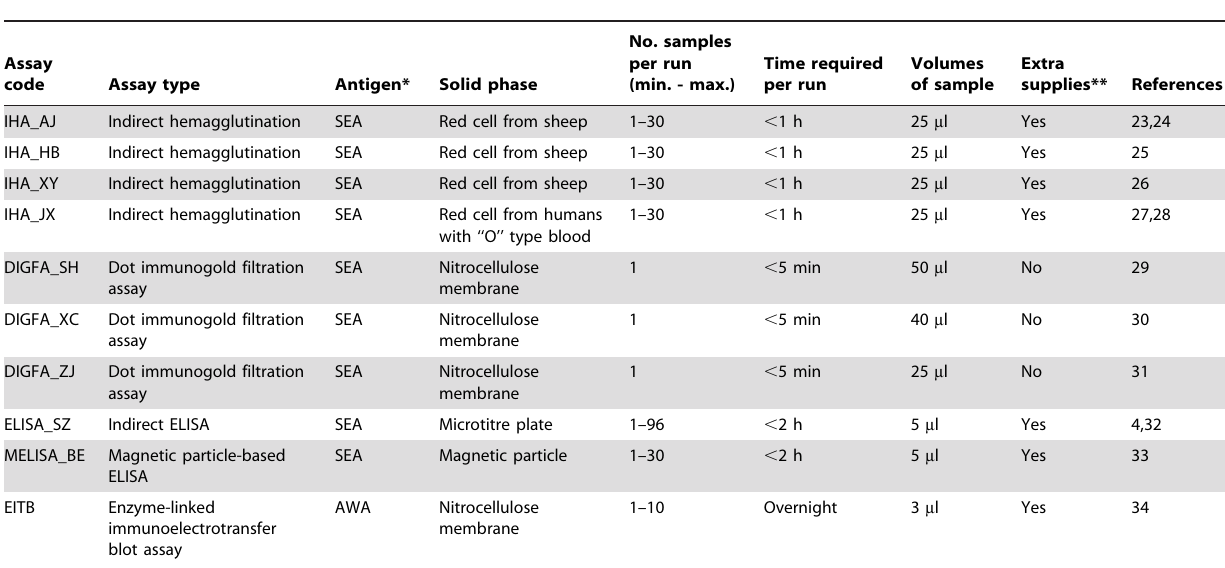
Table 1. Major features of the evaluated tests for the diagnosis of S. japonicum infection.